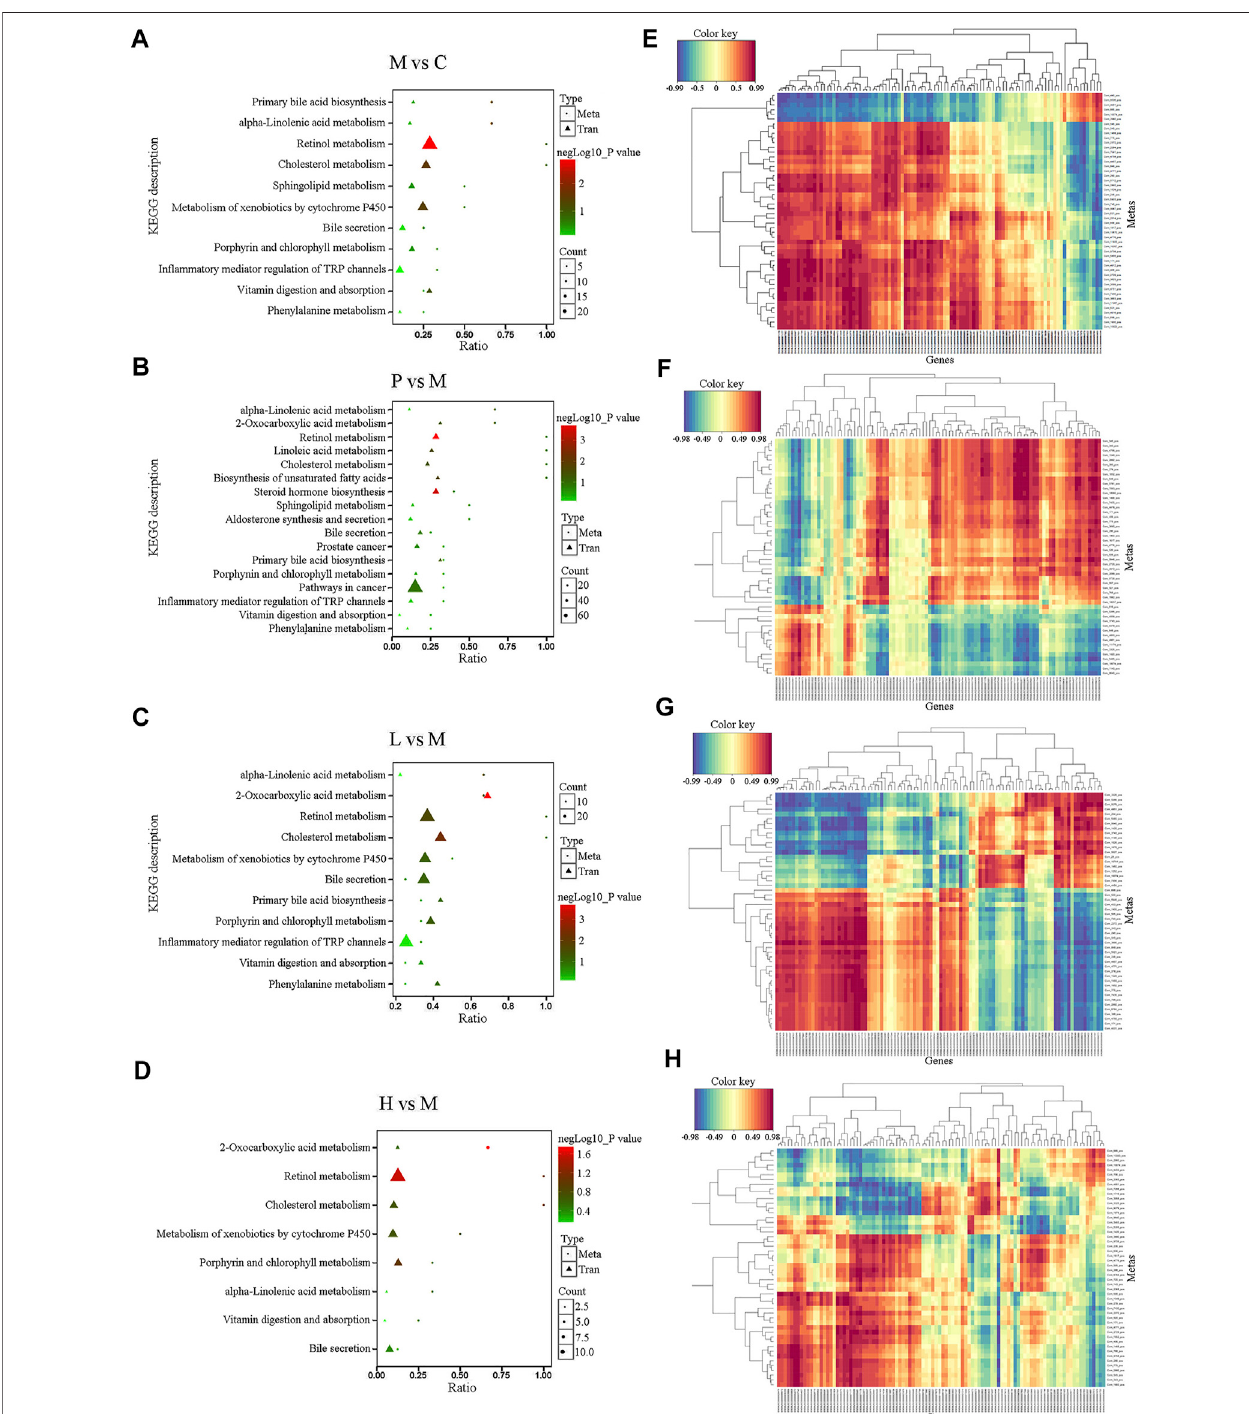
FIGURE5| Integratedanalysisofthemetabolomicandtranscriptomicdataunderthepositiveionmode. (A – D) Integratedalteredmetabolicpathwaysaccordingto the metabolomic and transcriptomic data. The horizontalaxis shows the ratioof differential expressed genesand the vertical axis indicated the pathway name [ (A) M vs. C; (B) Pvs.M; (C) Lvs.M;and (D) Hvs.M]. (E – H) Integratedanalysisusingmetabolomicandtranscriptomicdata.Thehorizontalaxisshowstheclusteringofdifferential expressed transcripts and the vertical axis indicated the clustering of differential expressed metabolites. The red depth represents the strength of the positive correlation. The blue depth represents the negative correlation [ (E) M vs. C; (F) P vs. M; (G) L vs. M; and (H) H vs. M].